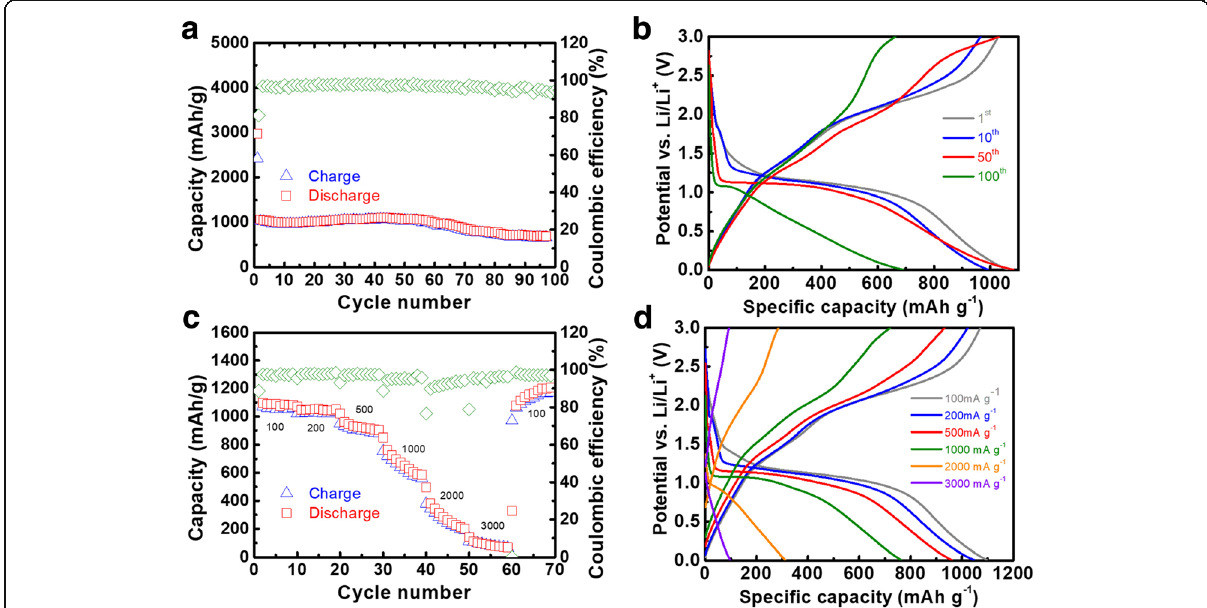
Fig. 8 a Cycling performance of NiCo 2 O 4 tested at a current density of 100 mA g − 1 . b Typical charge-discharge curves of NiCo 2 O 4 tested at 100 mA g − 1 for the 1st, 10th, 50th, and 100th cycle c rate capability performance. d Typical charge-discharge curves of NiCo 2 O 4 tested at different current densities ranging from 100 to 3000 mA g −